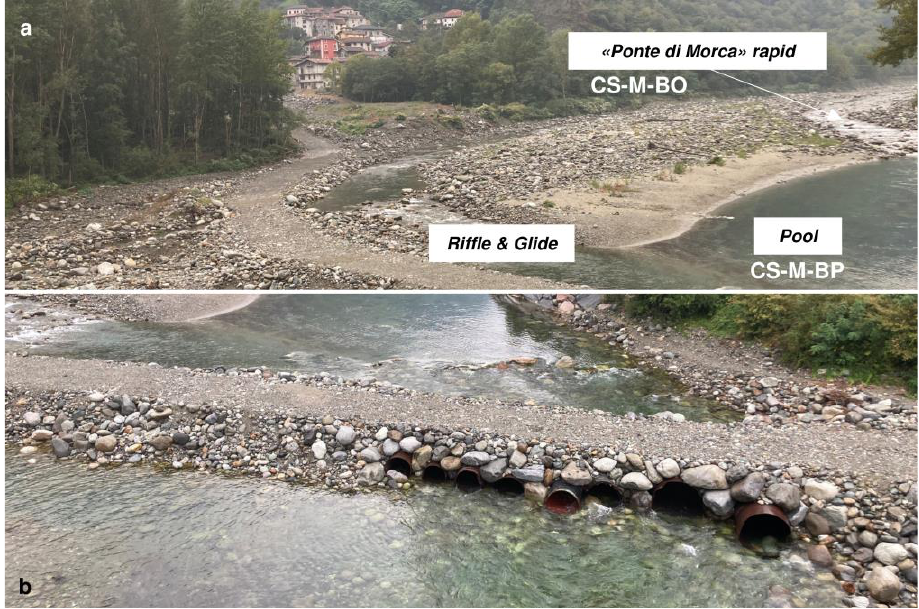
Figure 12. Examples of human intervention in the bankfull after the 2020 event. ( a ) The Ponte di Morca rapid (CS-M-BO), followed by a long pool (CS-M-BP) and the alternative channel, characterized by a good example of riffles and glides, even if not used for rafting activity; ( b ) CS-M- BP, human intervention provoking the creation of syphons and holes CS-M-BO. See location in Figure 8. For abbreviations, please see Section